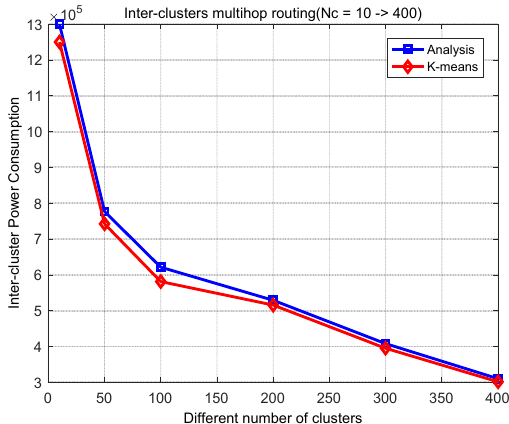
Figure 12. An illustration of a total inter-cluster power consumption; a WSN with 2000 sensors randomly deploying in a circular sensing area ( R ; BS at the center) 0 = 50 Figure 12 depicts the total inter-cluster power consumption ( P toBS ) to forward M measurements